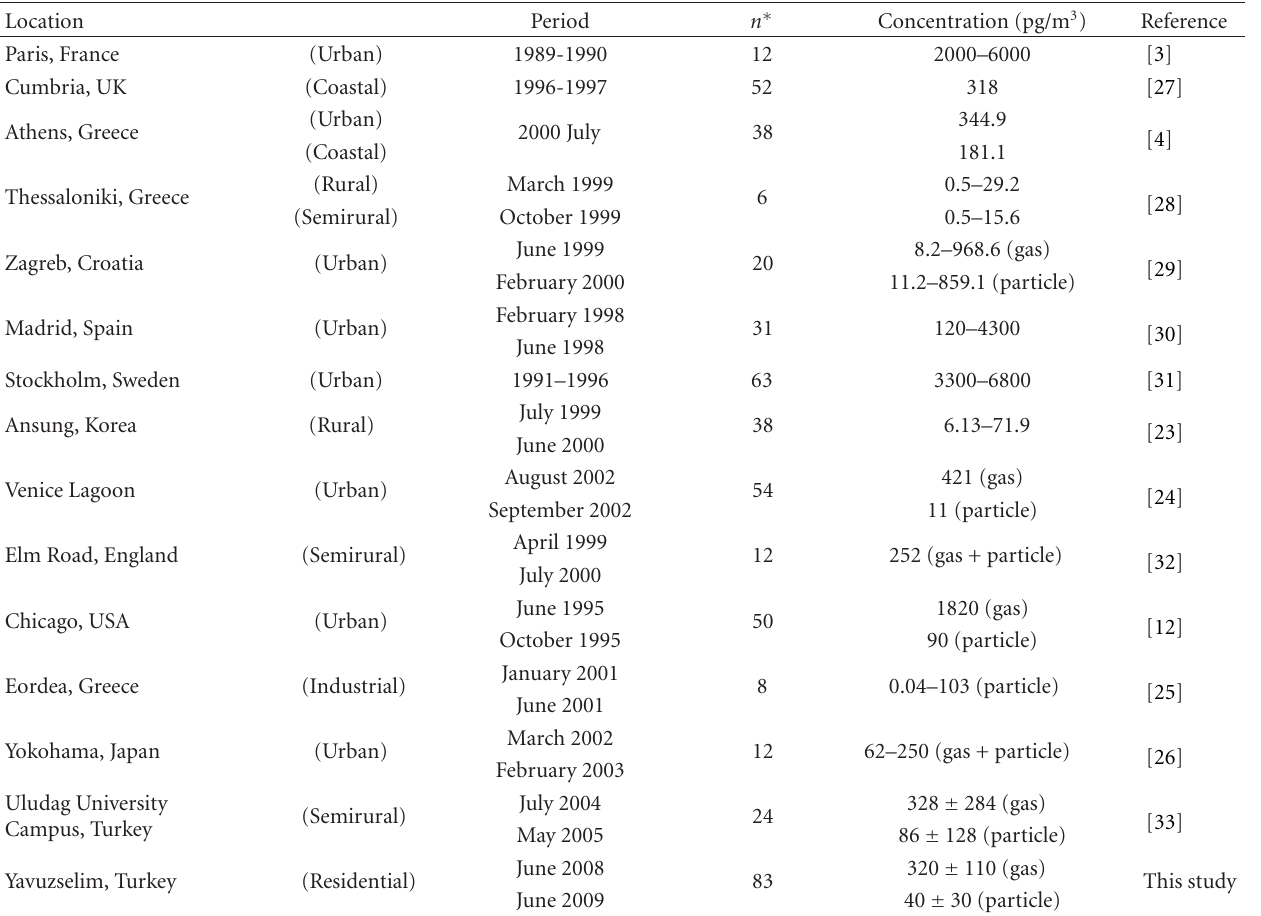
Table 3: Atmospheric concentrations of PCBs at various